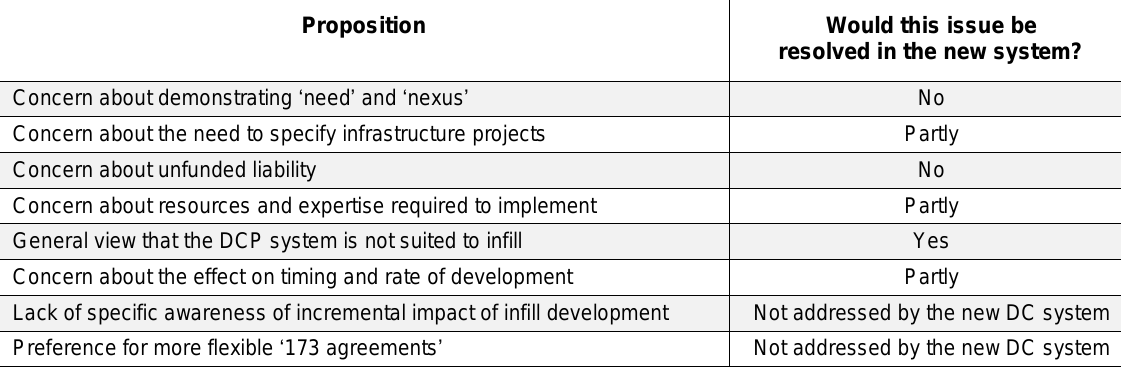
Table 3: Summary of findings from Hume City Council case